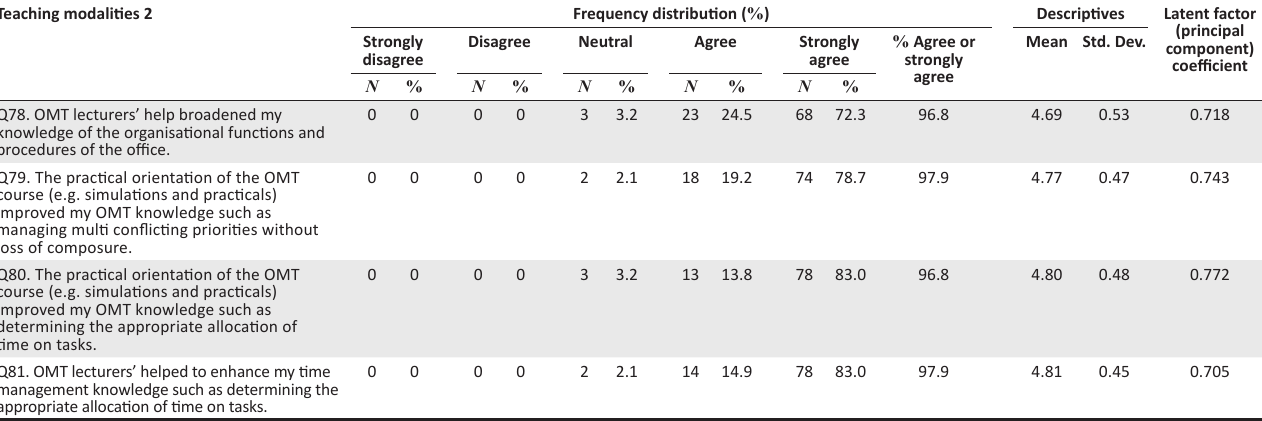
TABLE 12: Influence of teaching modalities